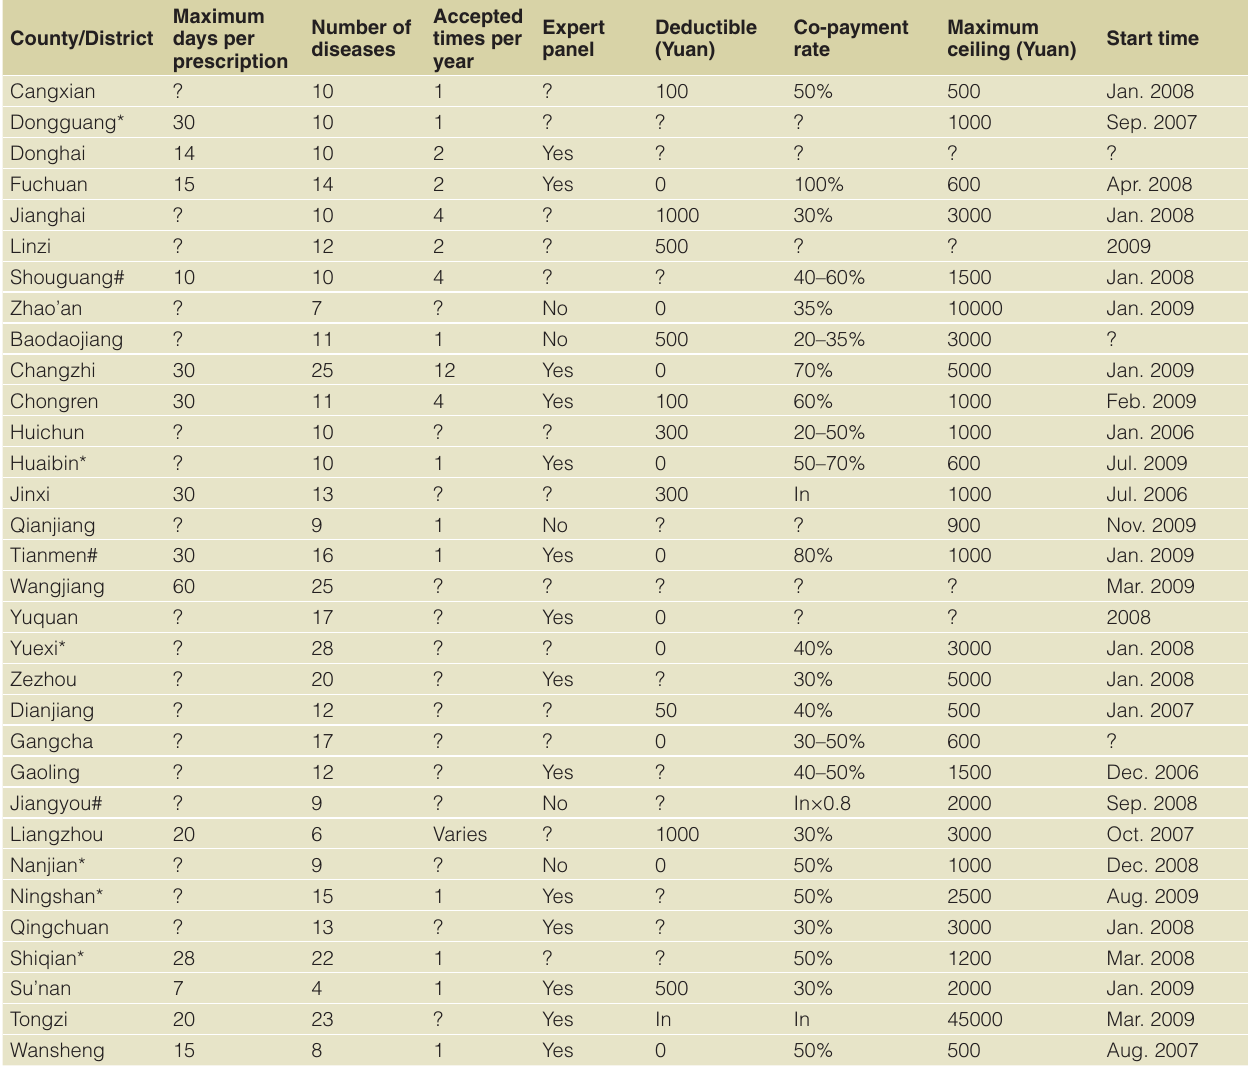
Table 1. General information on benefit packages in 32 counties. Maximum County/District days